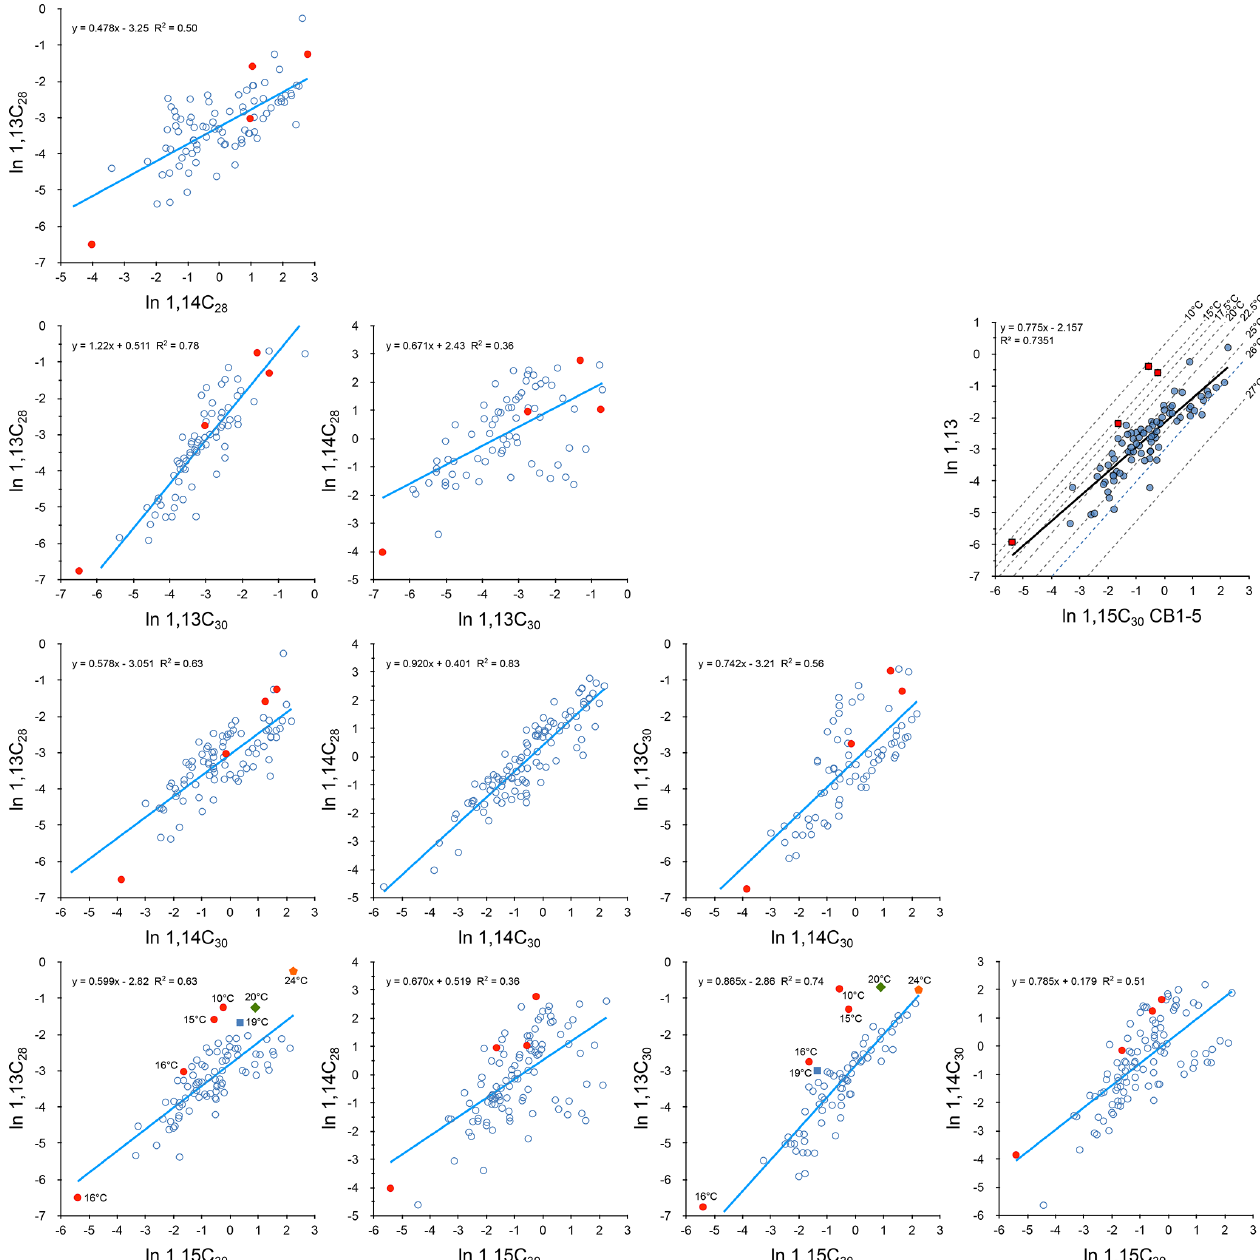
Figure 8. Cross plots of log-transformed diol fluxes (µgm − 2 d − 1 ) with 1,13 diol values for samples providing SST LDI values below 18 ◦ C in solid red. These values have not been included for obtaining the (blue) regression lines. In 1,13 × 1,15 diol plots other extreme points are indicated by a blue square (19 ◦ C), green diamond (20 ◦ C), and orange pentagram (24 ◦ C). In the upper right plot, the diols involved in the LDI (1,15C 30 and combined 1,13 diols) are provided. The dotted lines represent isotherms for the transfer function of Rampen et al. (2012). The regression line shows how the (log-transformed) composition of the diols involved in the LDI relates to temperature (excluding the outliers indicated by red